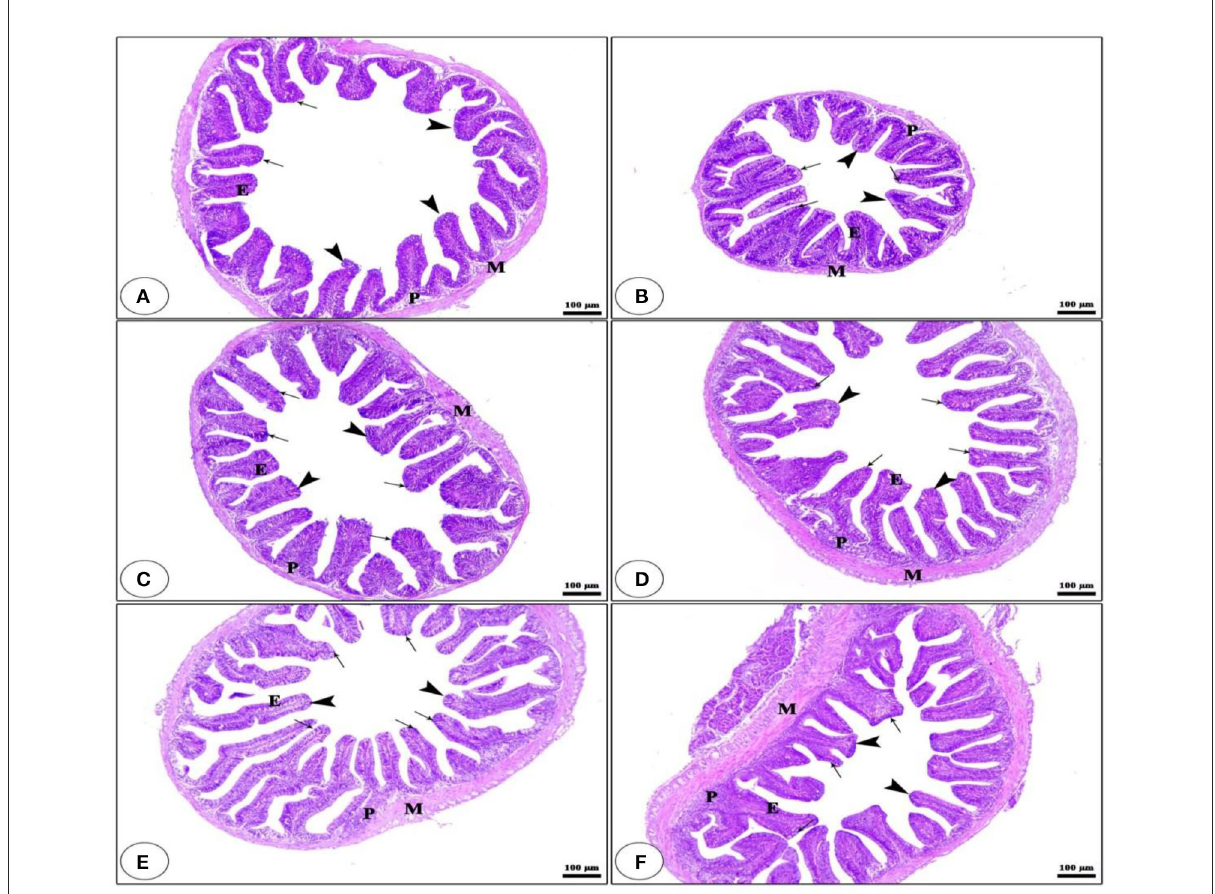
FIGURE1 Histological description for transversal section photomicrograph of O. niloticus anterior part of intestine. While, CNT (A) , BG (B) , BC1 (C) , BC2 (D) , BG + BC1 (E), and BG + BC2 (F) . The intestinal villi (arrow heads) with intact simple columnar epithelium (E) rested on lamina propria of loose connective tissue (p) and lamina muscularis (M) with numerous goblet cells (arrows) present in the lamina epithelia. The examined sections stained with H&E ( × 100 µ